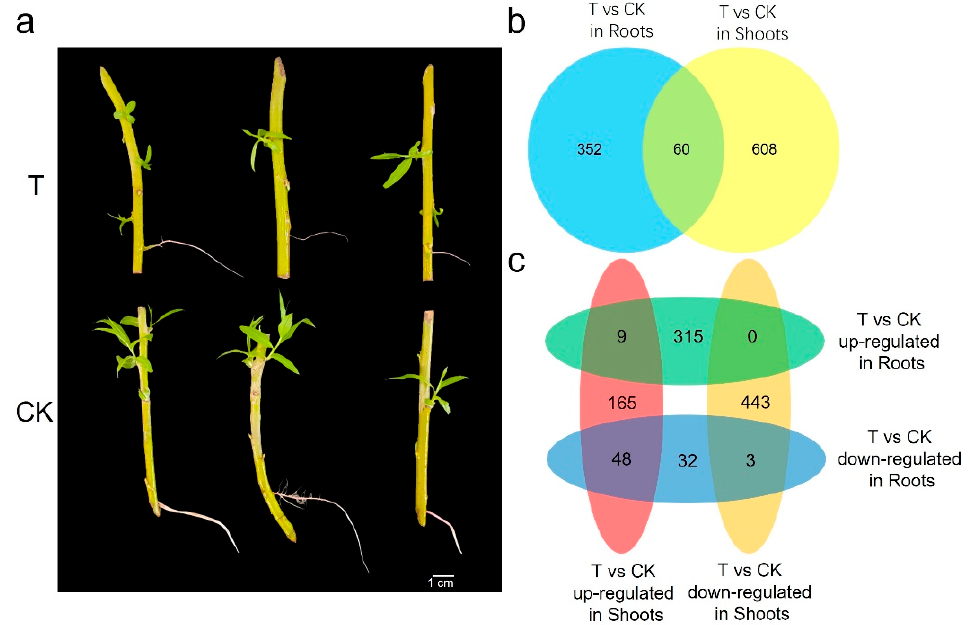
Figure 1. The roots and shoots showed different responses to gravity: ( a ) the phenotypes of the roots and shoots under normal and inverted conditions; ( b ) Venn analysis of the differentially expressed genes (DEGs) in the roots and shoots.; ( c ) Venn analysis of the up- and down-regulated DEGs in the roots and shoots.